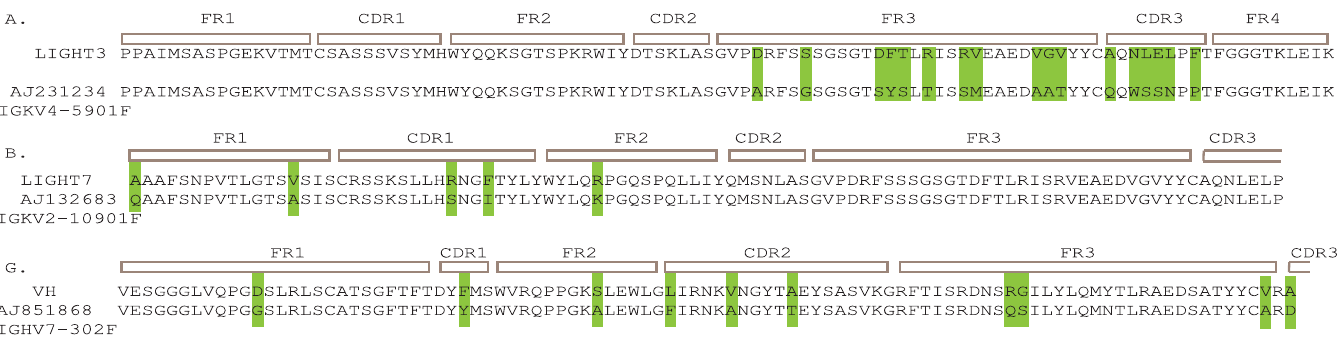
Fig 10. Predicted hypermutation events in scFV3 and 7. (A-C) The predicted hypermutation events that derived the scFv-3/7 (from the IMGT/V-QUEST web